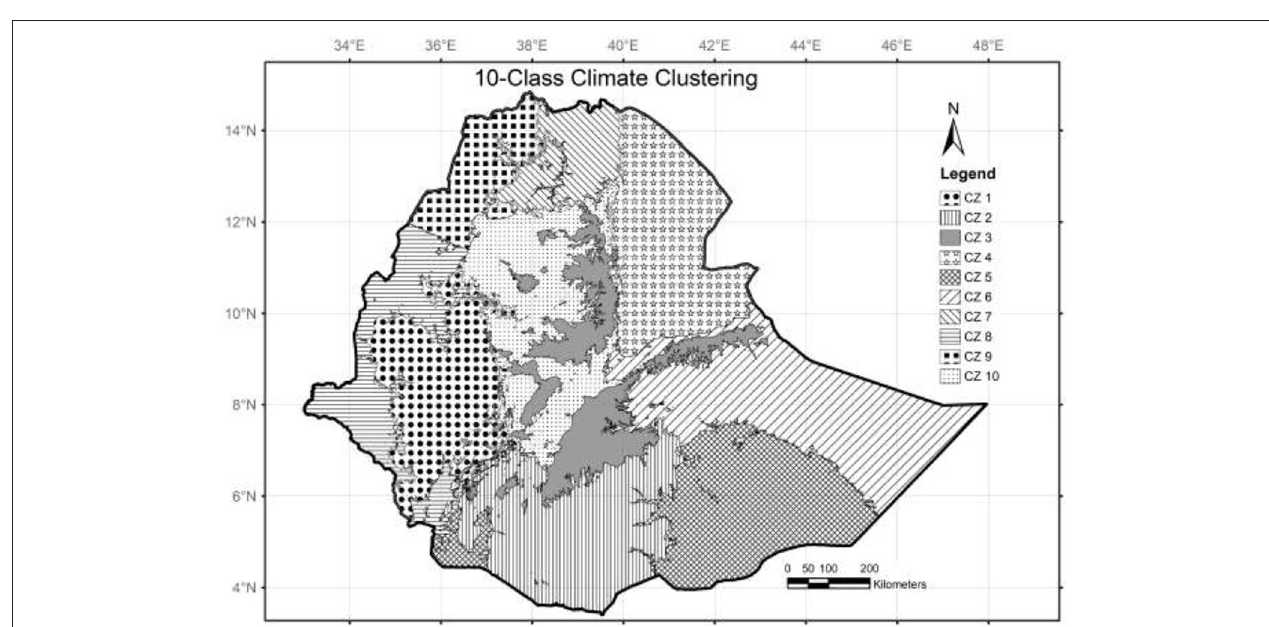
FIGURE 5 | Final climate